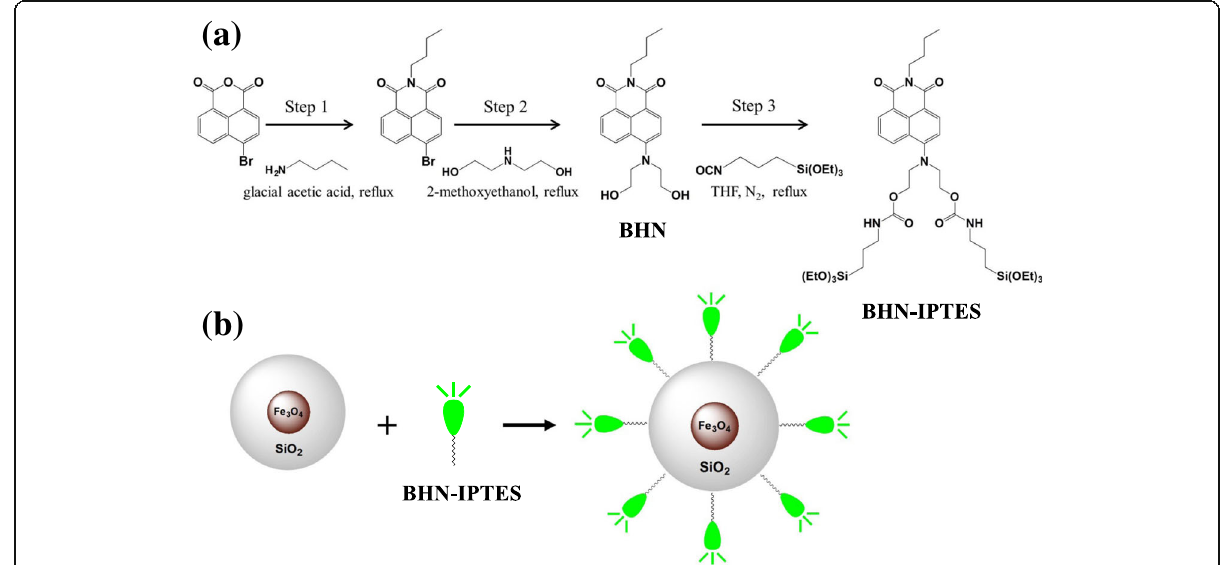
Fig. 1 a Synthesis of BHN. b Synthesis of BHN-Fe 3 O 4 @SiO 2